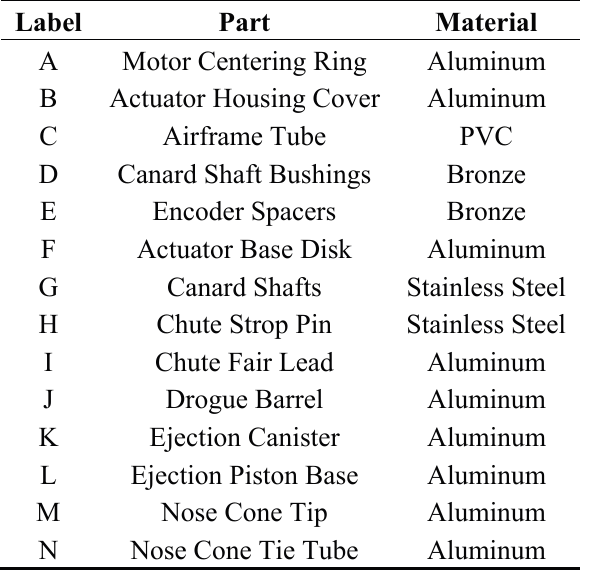
Table 2. Labelled Smokey rocket parts from Figure